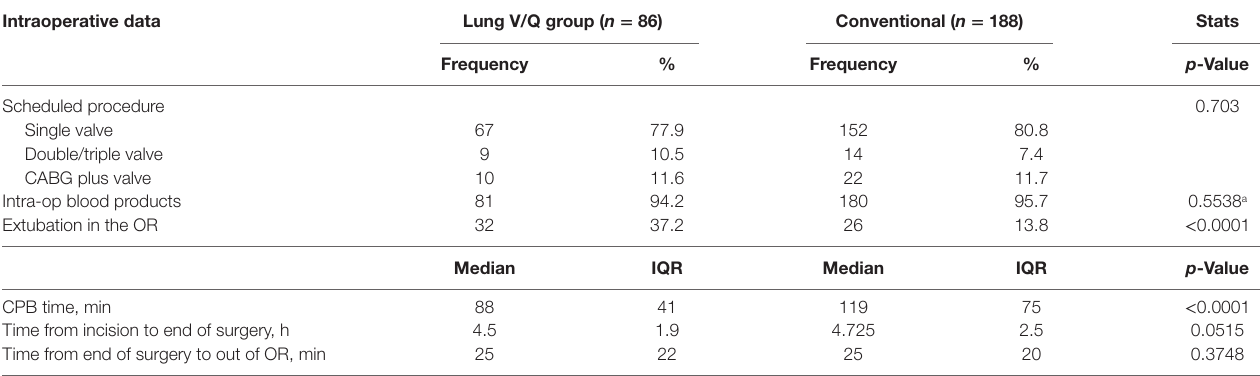
TaBle 2 | intraoperative data.